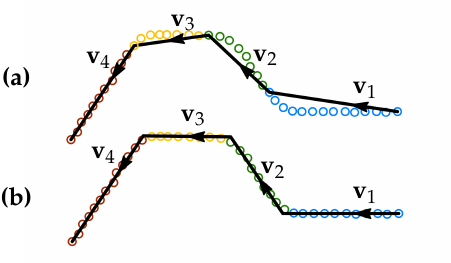
Figure 11. Input data ( a ) and the output ( b ) of the iterative error elimination algorithm. The different point colors indicate point sets associated with different segments, initial point association is shown in ( a ) and after the final iteration—in ( b ).